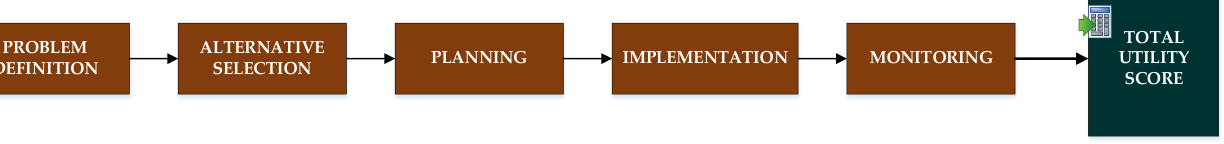
Figure 2. Augmented process mapping.